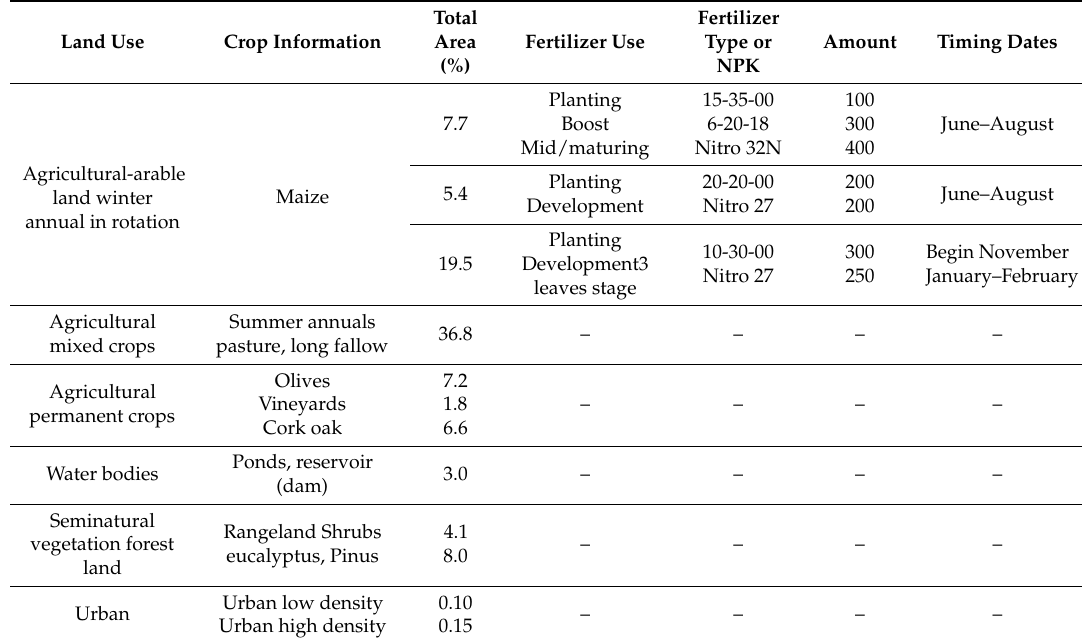
Table 1. Land use, cover, and crop management information in the upper Roxo catchment area